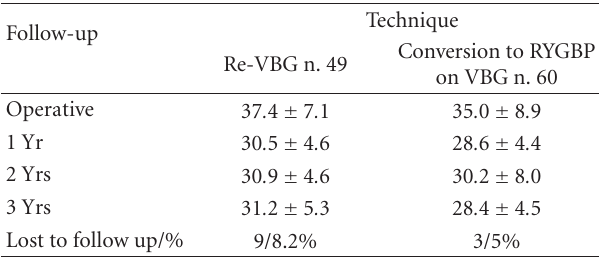
Table 6: Outcomes of revisionary surgery for failed or complicated VBGs: statistical study to compare changes in BMI between 2 groups.